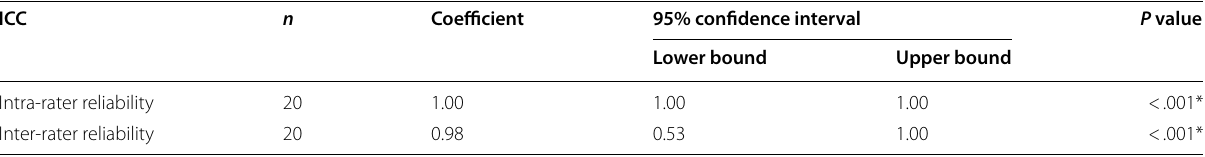
ICC indicates intra-class correlation coefficient; n, sample size; *, statistical significance